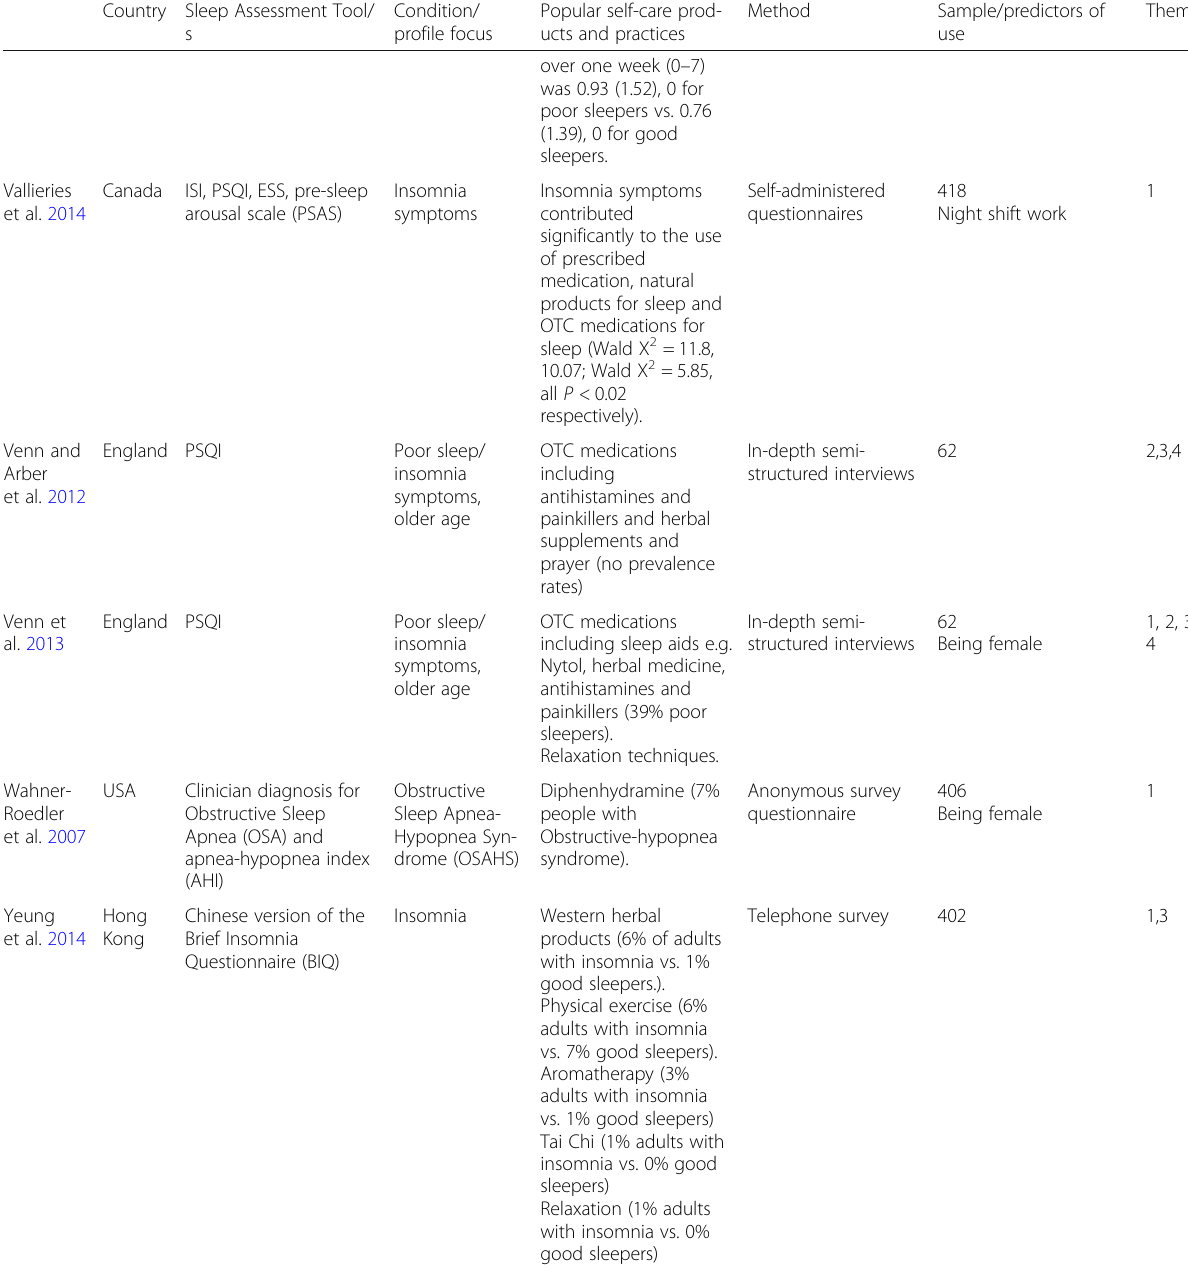
Table 1 Research-based studies of self-care for adults for sleep disturbances, 2006 – 2016 (Continued) Country Sleep Assessment Tool/